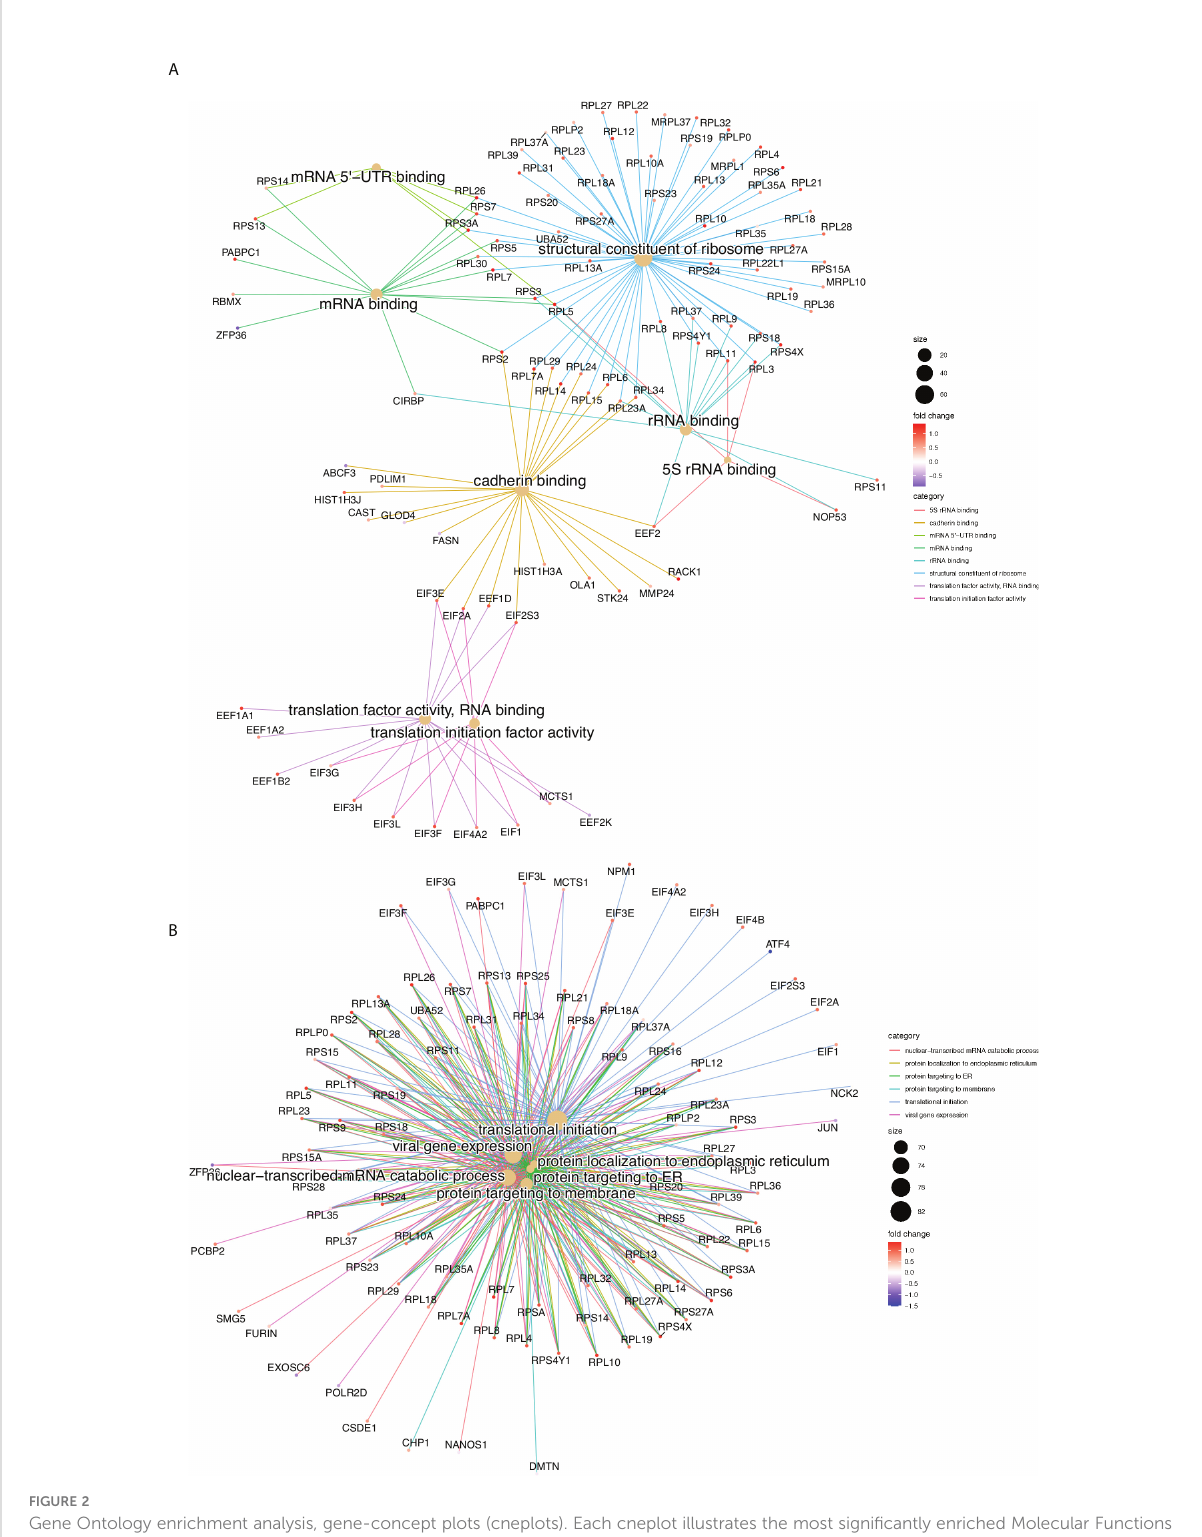
FIGURE 2 Gene Ontology enrichment analysis, gene-concept plots (cneplots). Each cneplot illustrates the most signi fi cantly enriched Molecular Functions (MF, A ) and Biological Processes (BP, B ) categories. Lines of the same colour connect genes of the same GO category and the colour gradient of each gene corresponds to its